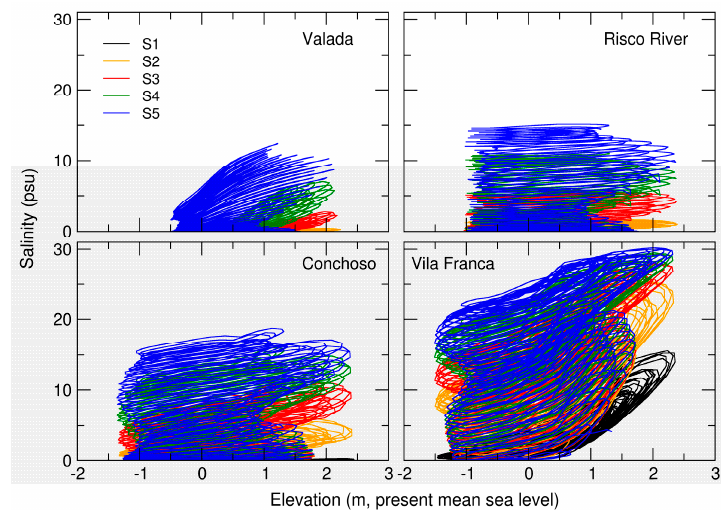
Figure 10. Relationship between the salinity and the tidal elevation for the river discharge scenarios: S1—climatological, S2—recent drought, S3—worst recent drought, S4—minimum river flow, and S5 —worst-case scenario. Geosciences 2019 , 9 , x FOR PEER REVIEW